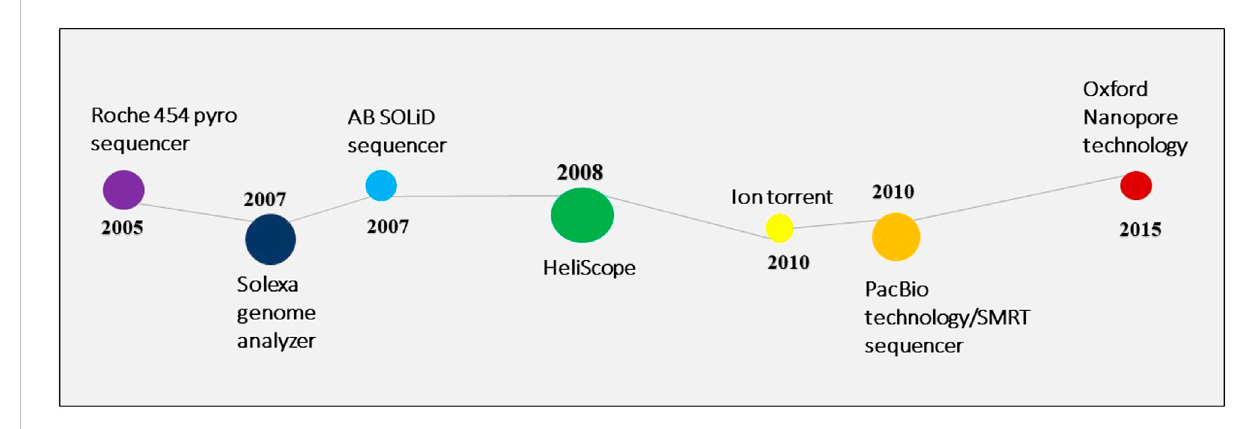
FIGURE 2 The inventions in the NGS